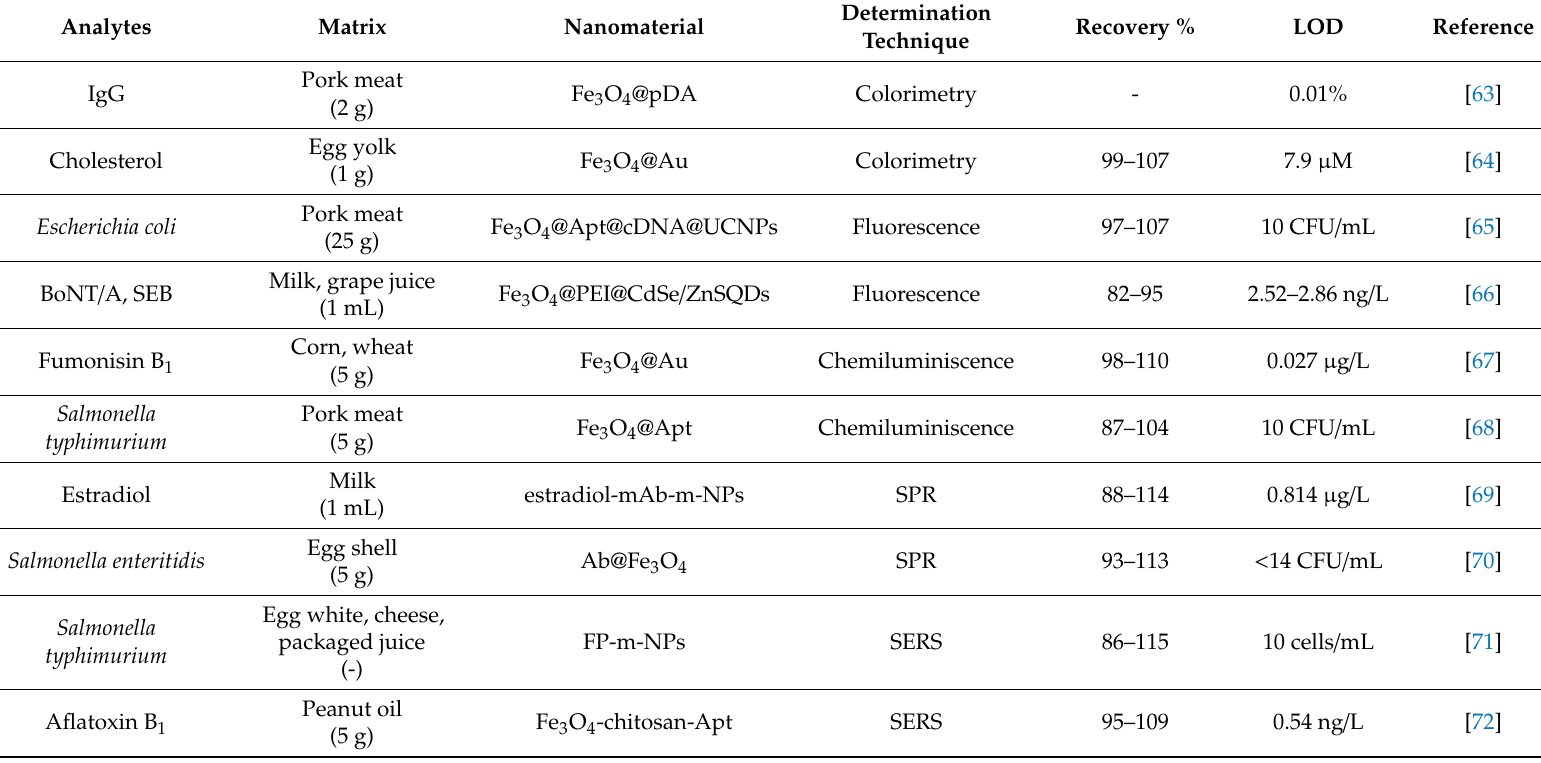
Table 4. Novel applications of magnetic nanoparticles based on optical sensors in food